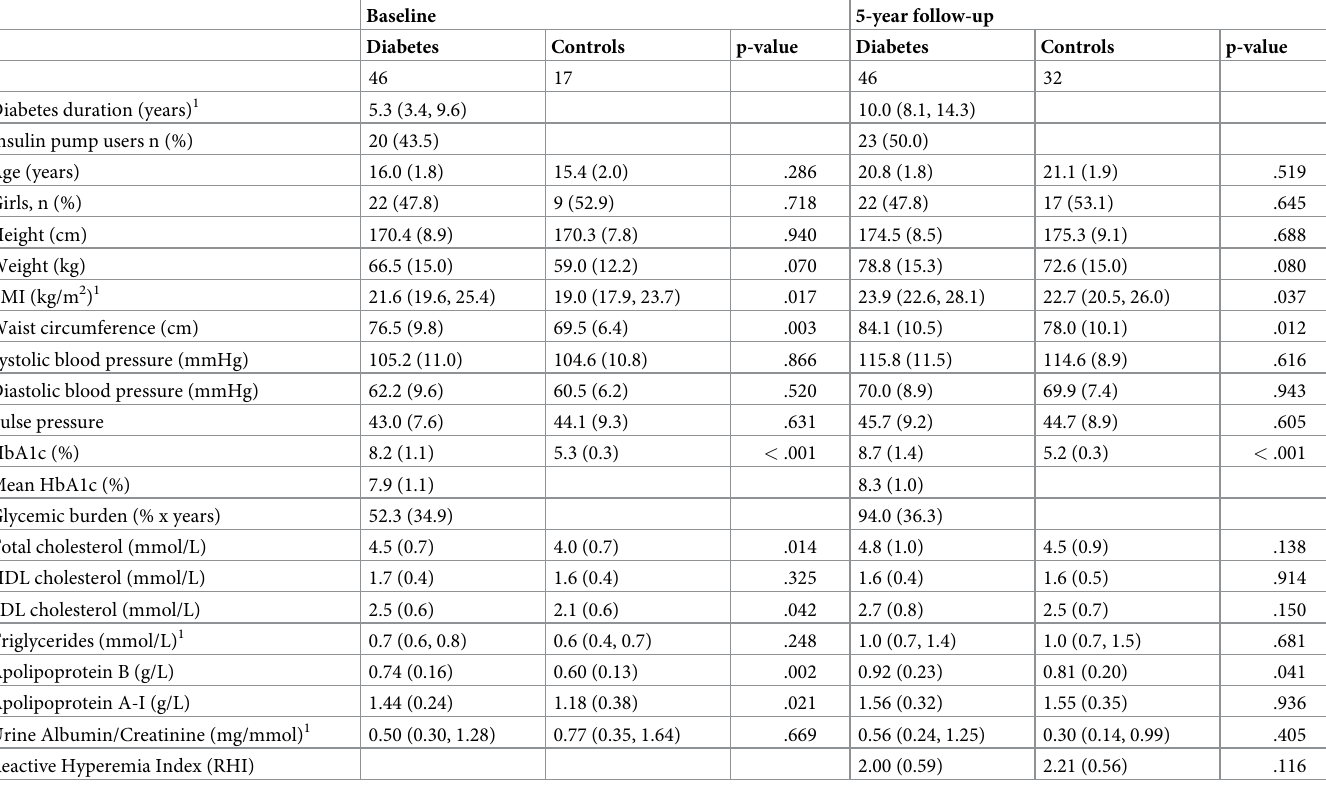
Table 1. Clinical and metabolic